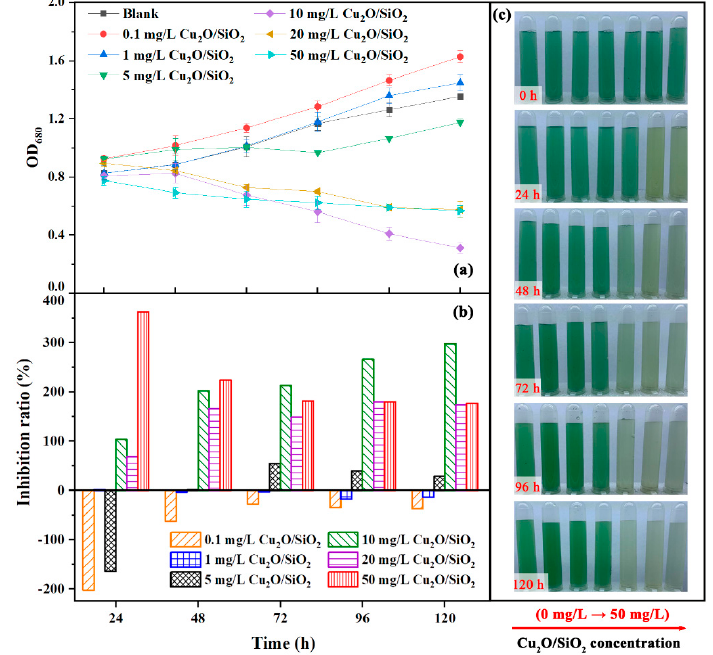
Figure 2. The growth of M. aeruginosa after treatment with different concentrations of Cu 2 O/SiO 2 . ( a ) OD 680 value; ( b ) Inhibition rate; and, ( c ) The color change of algae during the experiment.